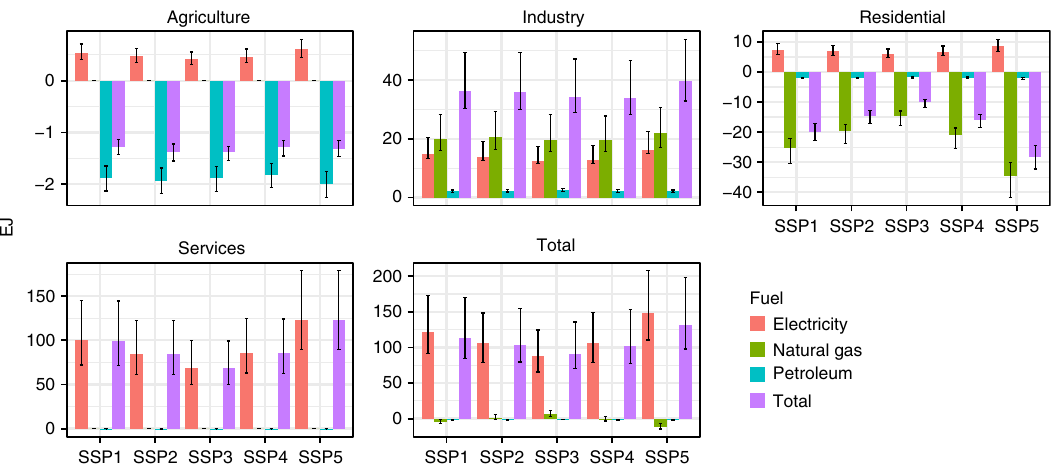
Fig. 3 Global total energy demand ampli fi cation from climate change around 2050 under RCP 8.5. Solid bars represent the median of 21 ESM model simulations, error bars represent the interquartile range of change in energy demand across 21 ESM simulations (see Supplementary Fig. 8 for RCP 4.5 results)